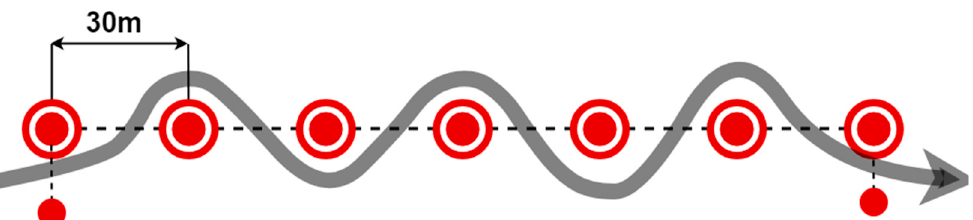
Figure 16. Slalom test course.